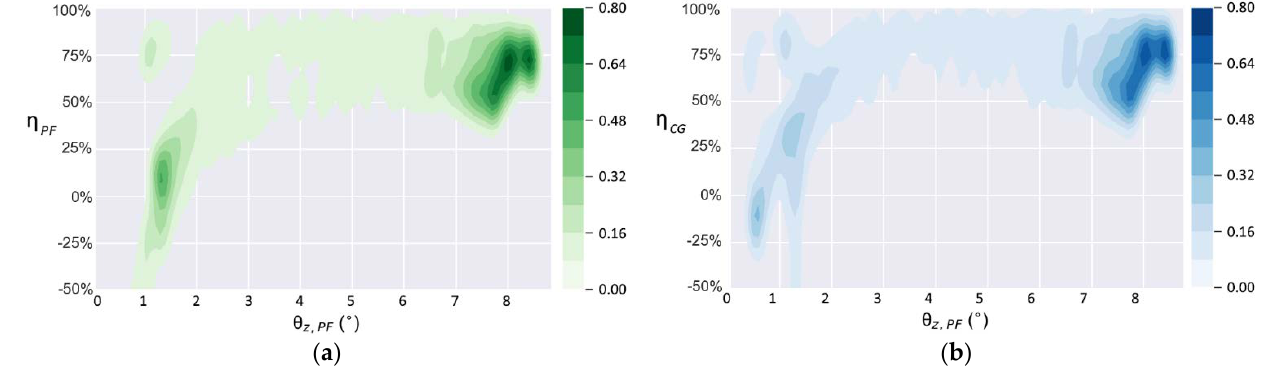
Figure 17. Density distribution of balance efficiencies when T = 10 s: ( a ) η PF ; ( b ) η CG .